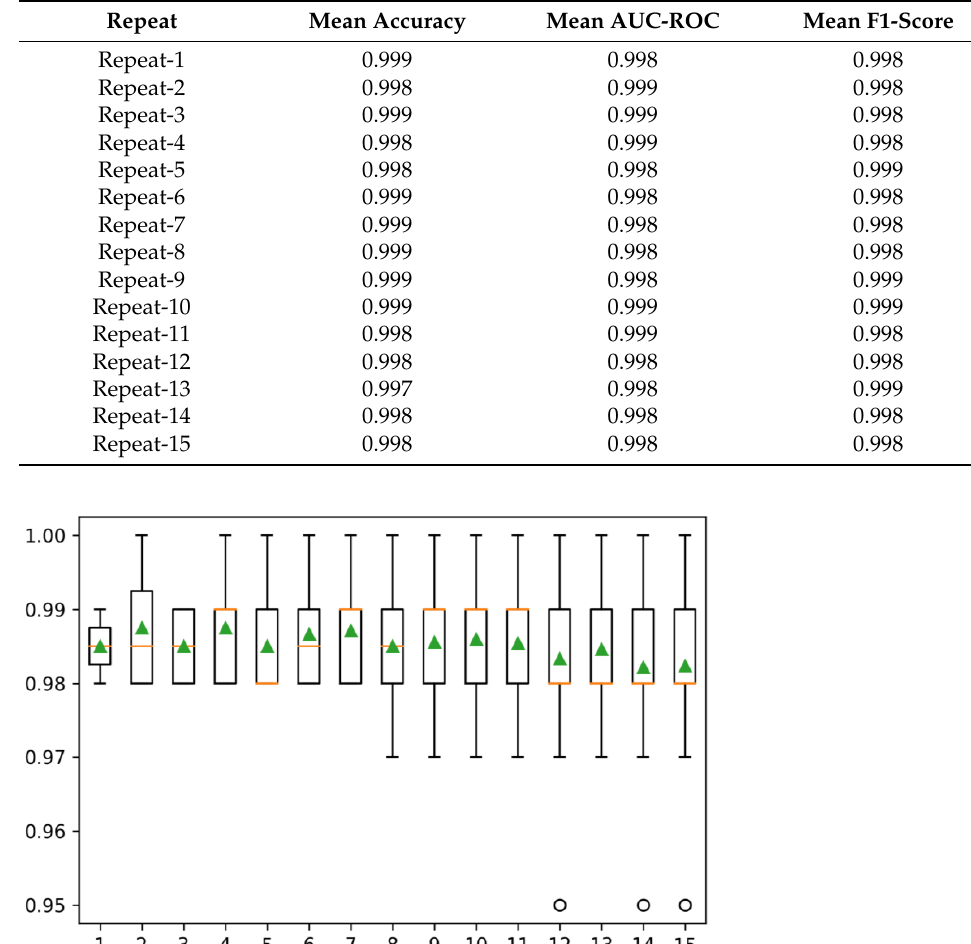
Table 3. Evaluation of XGBoost on Extended Dataset using repeated 10-fold Cross-Validation (Mean of 10 Folds for 15 repeats).